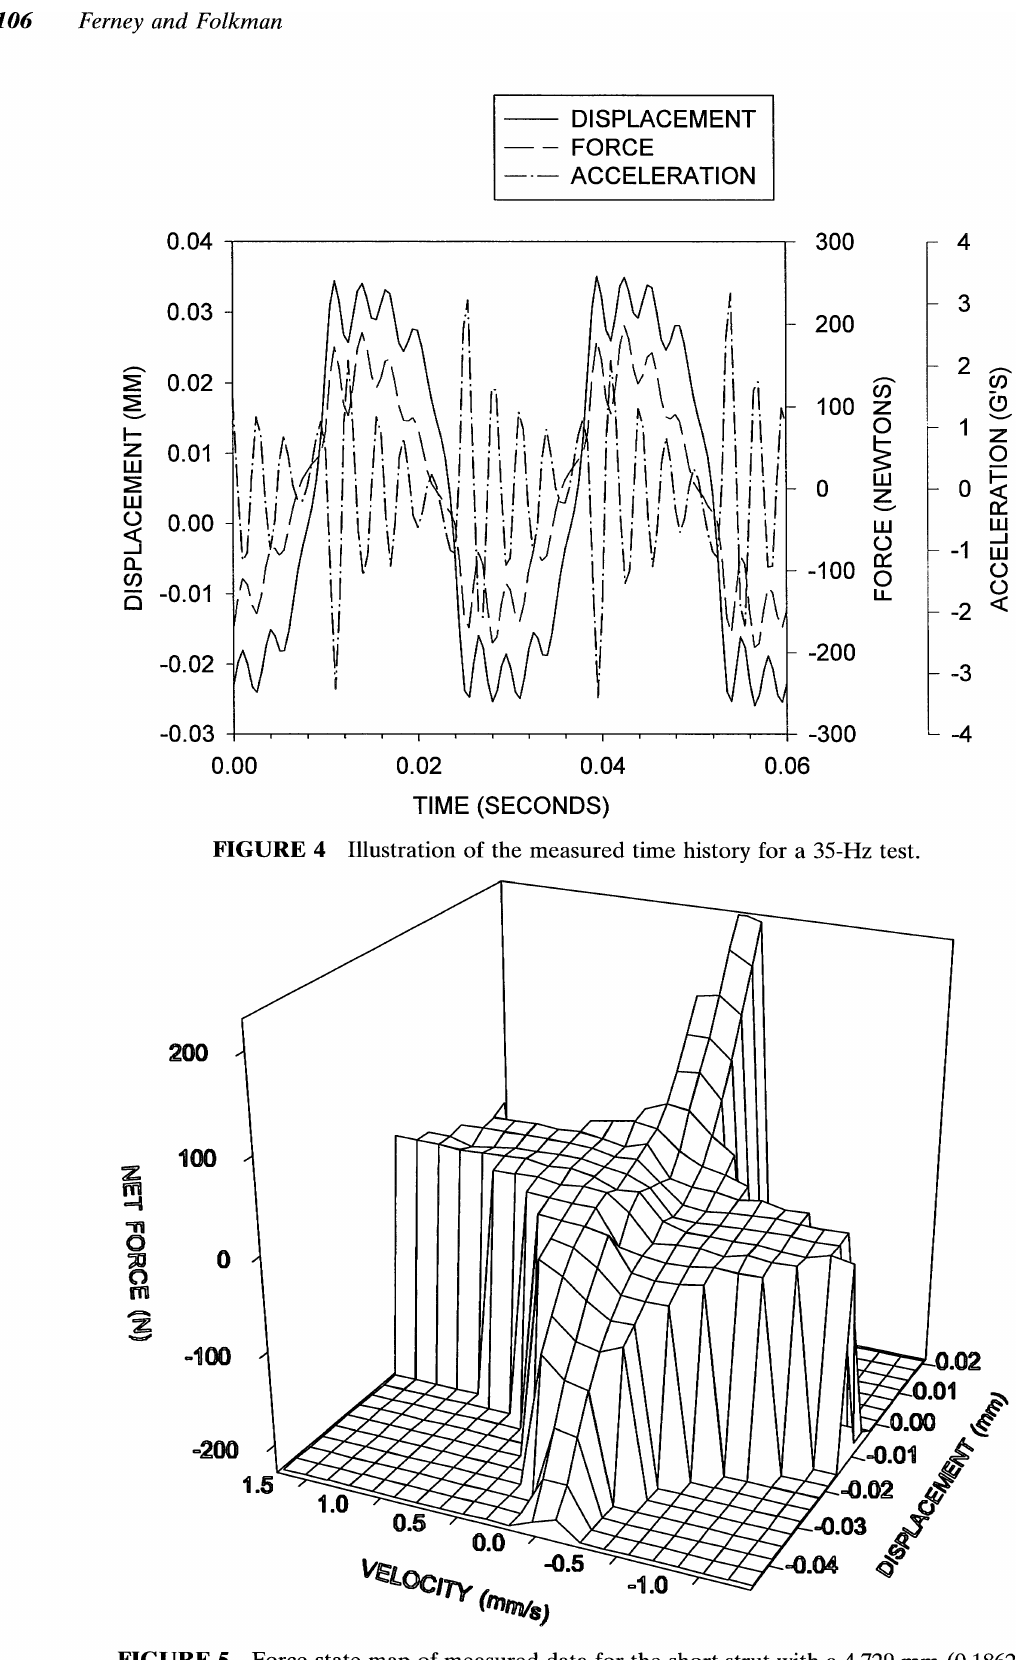
FIGURE 5 Force-state map of measured data for the short strut with a 4.729 mm (0.1862 in.) pin and I-Hz forcing